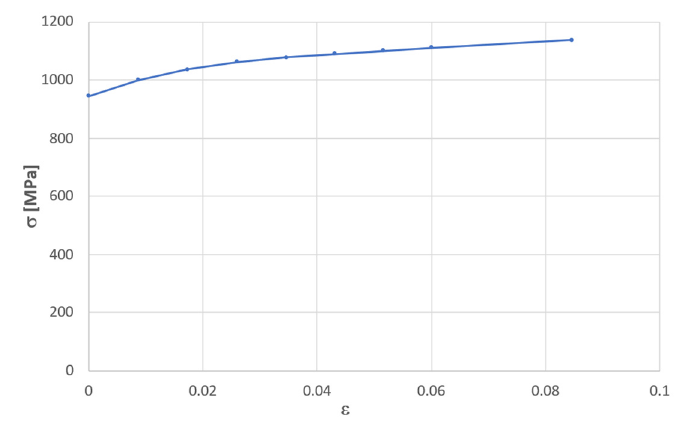
Figure 3. Plastic stress–strain curve for steel used in M30 class 10.9 bolts.